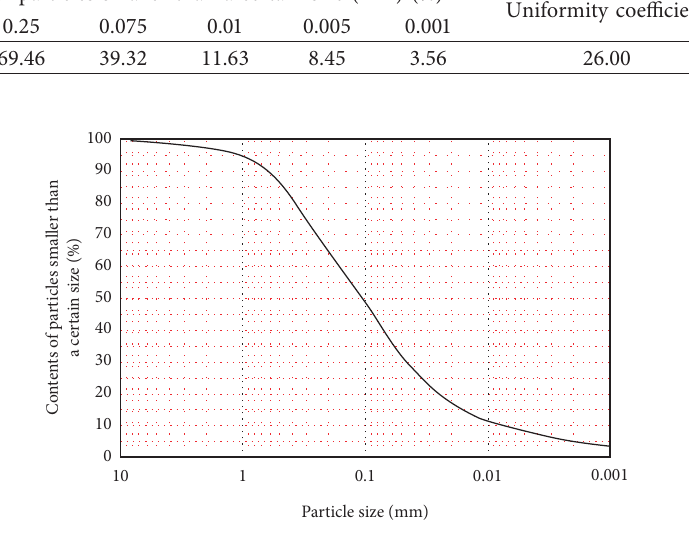
Figure 3: Grading curve of silty clay in muck. Table 3: Particle size composition of fine sand in